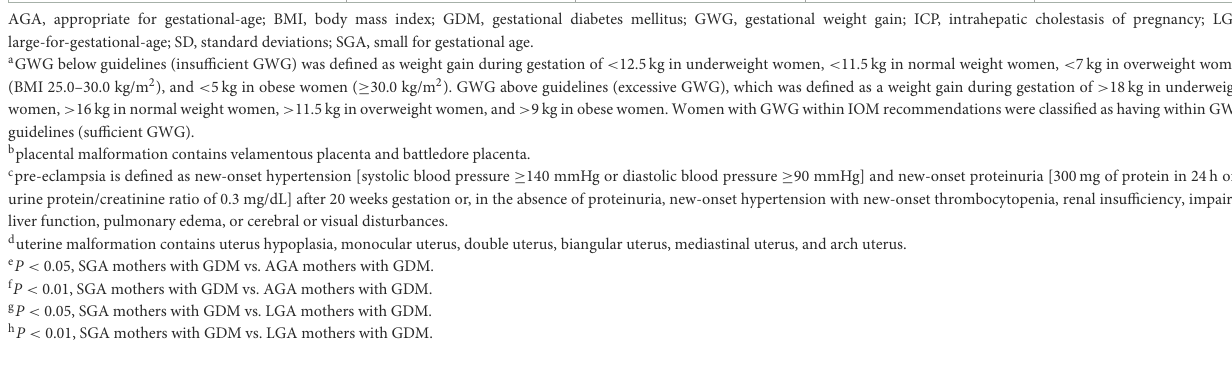
b placentalmalformationcontainsvelamentousplacentaandbattledoreplacenta. c pre-eclampsia is defined as new-onset hypertension [systolic blood pressure ≥ 140 mmHg or diastolic blood pressure ≥ 90 mmHg] and new-onset proteinuria [300mg of protein in 24h or a urine protein/creatinine ratio of 0.3 mg/dL] after 20 weeks gestation or, in the absence of proteinuria, new-onset hypertension with new-onset thrombocytopenia, renal insufficiency, impaired liverfunction,pulmonaryedema,orcerebralorvisualdisturbances. d uterinemalformationcontainsuterushypoplasia,monocularuterus,doubleuterus,biangularuterus,mediastinaluterus,andarchuterus. e P < 0.05,SGAmotherswithGDMvs.AGAmotherswithGDM. f P < 0.01,SGAmotherswithGDMvs.AGAmotherswithGDM. g P < 0.05,SGAmotherswithGDMvs.LGAmotherswithGDM. h P <